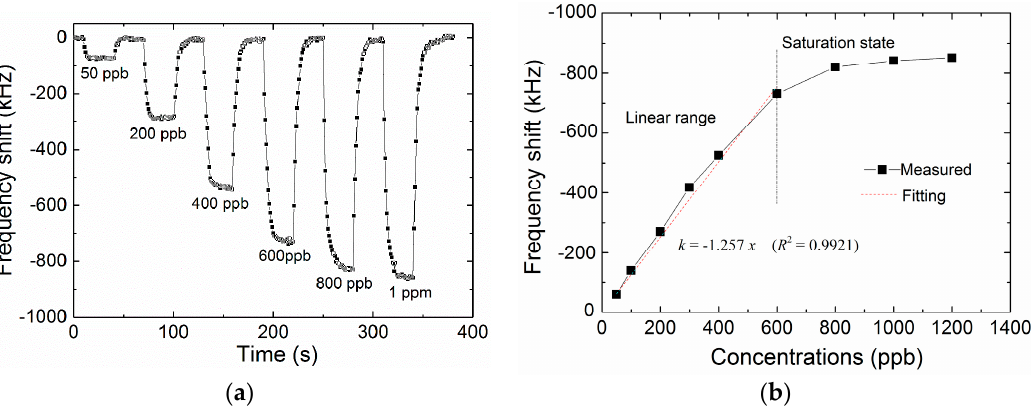
Figure 8. ( a ) Dynamic measurement of the FBAR sensor coated with PEI nanofibers exposed to the formaldehyde pulses with increasing concentrations at room temperature and 40% relative humidity; ( b ) Dependence of the frequency shift on the formaldehyde concentration.